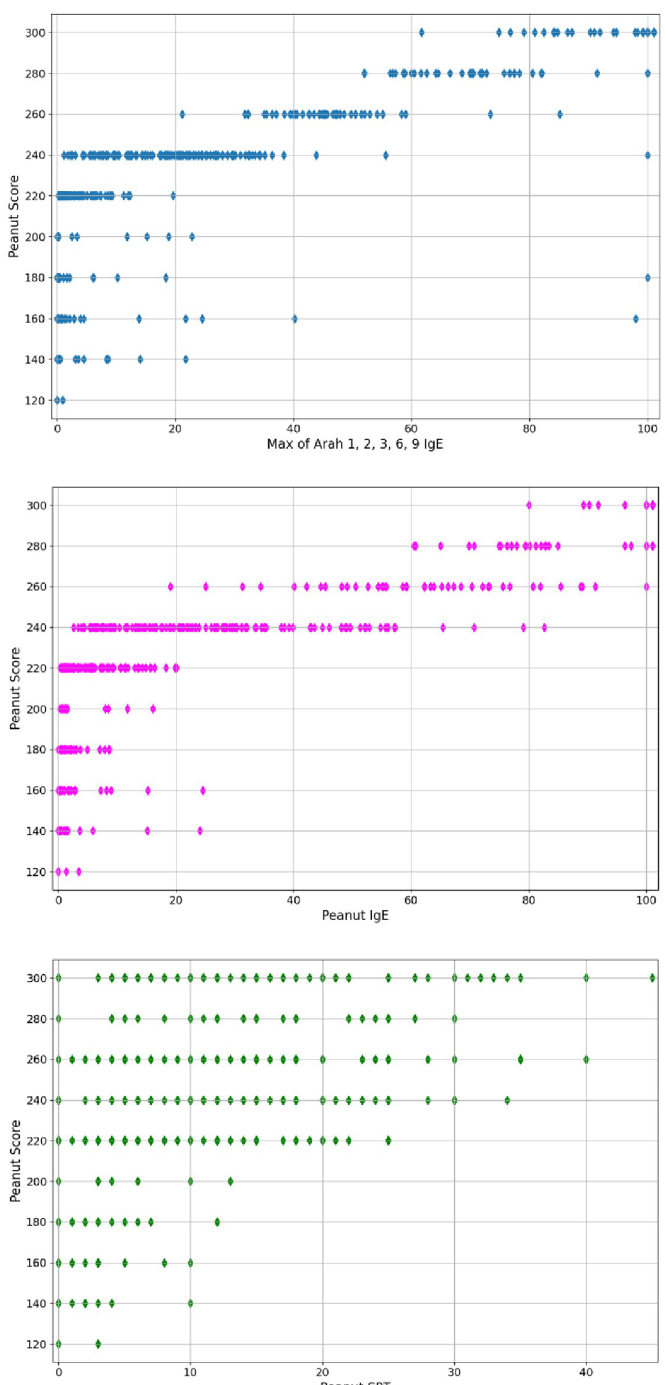
Fig 3. Correlation between the dependent variable (peanut allergy score) and some relevant predictors. Absolute peanut allergy scores 120–200 can be interpreted as Sen20 to Sen100, and scores 220–300 as Ana20 to Ana100. By design, arahs = max(arah_1, ... ,